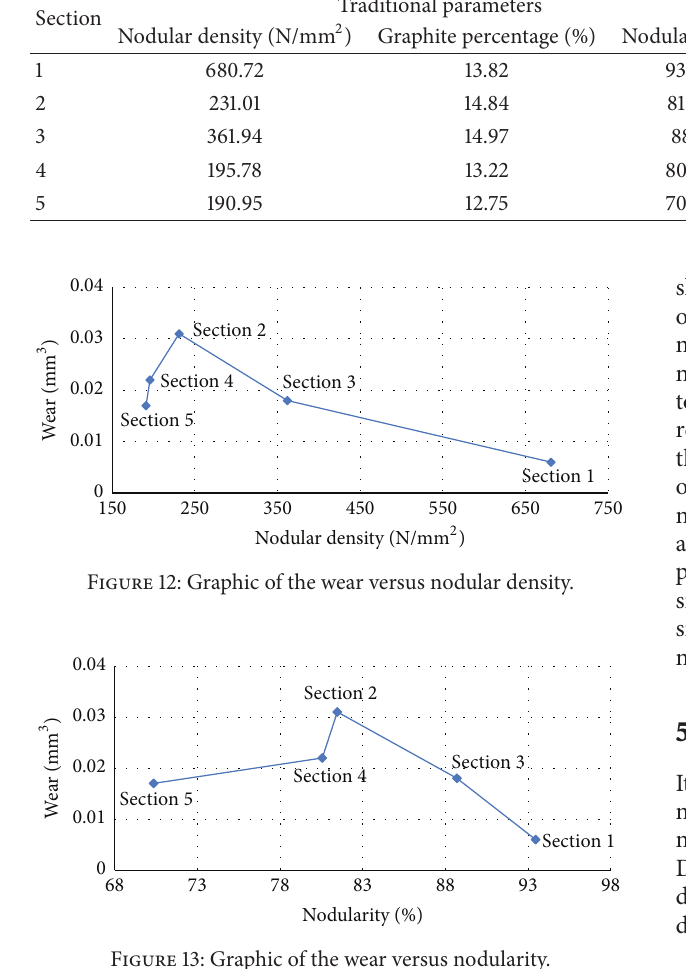
Figure 13: Graphic of the wear versus